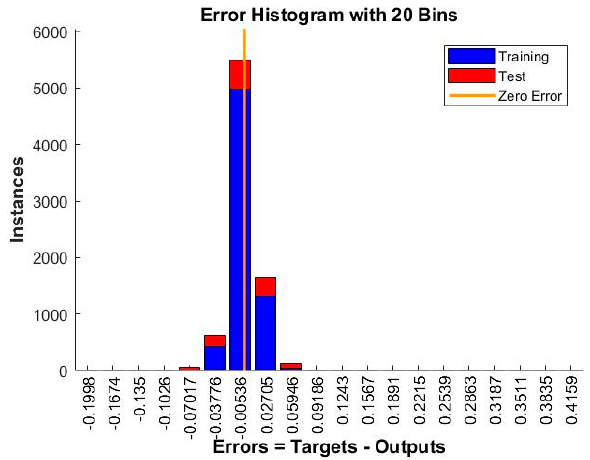
Figure 11. The error histogram when forecasting the electricity consumption for the month of December, using the ANN_NARX_BR_ALL network.